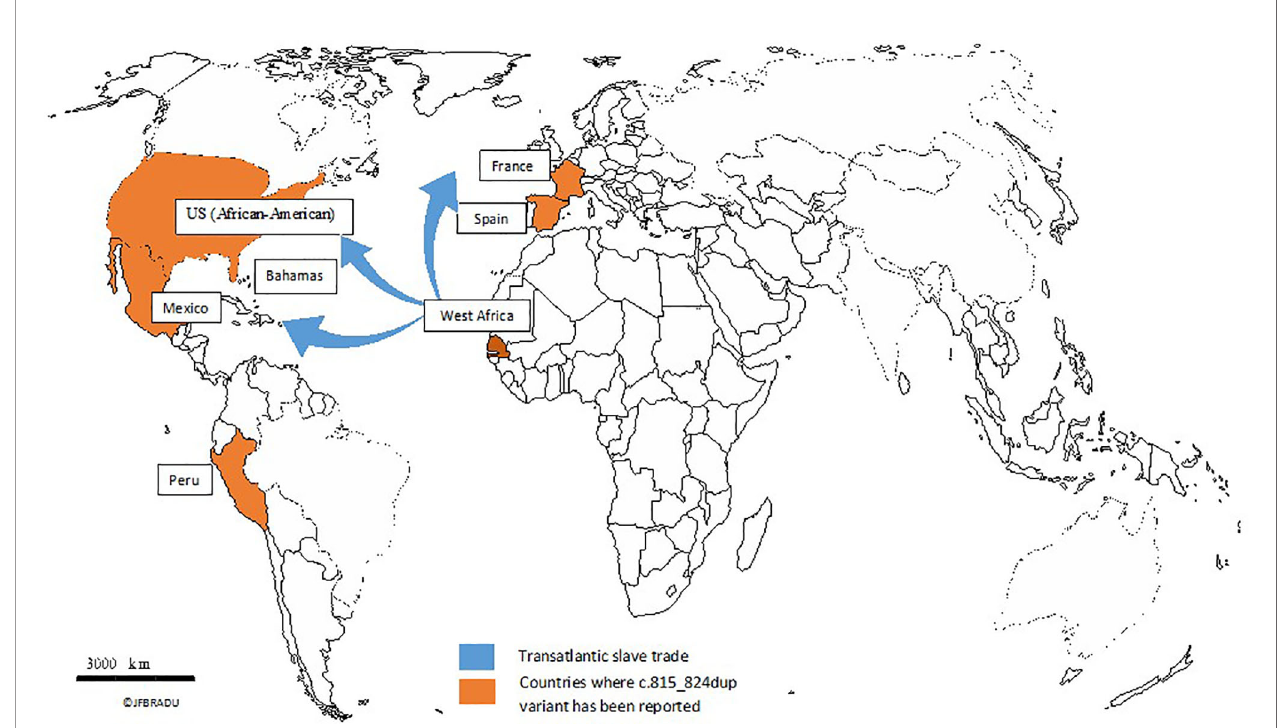
FIGURE 1 | Distribution of the BRCA1 c.815_824dup variant through the transatlantic slave trade from West Africa to other